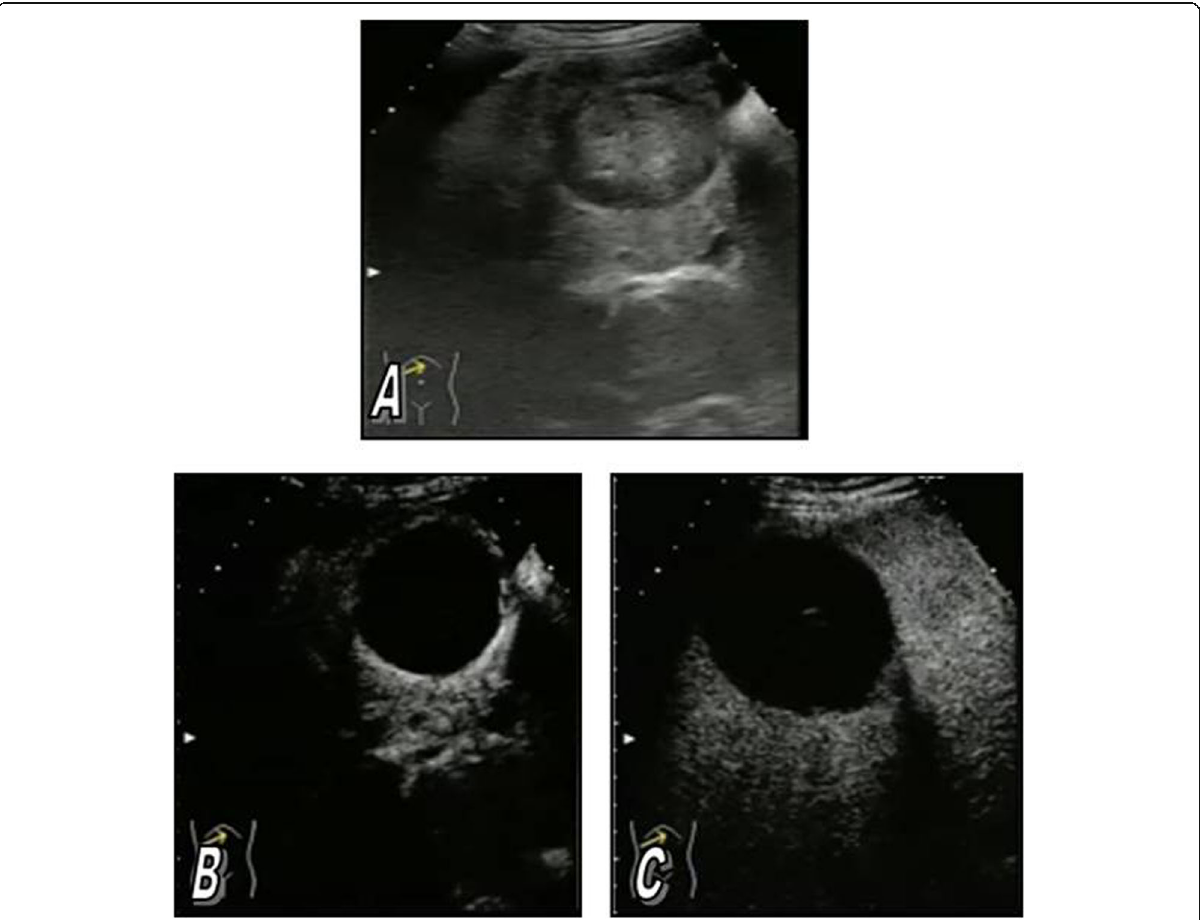
Fig. 4 A 58-year-old female, HCV – ve with history of pathologically proven ovarian cancer. a NEUS revealed average-sized liver showing left lobe segment IV isoechoic lesion measuring about 6.3 cm. CEUS revealed rim enhancement in the arterial phase ( b ) and the lesion is non-enhancing in late phase ( c ), suggesting hypovascular metastasis